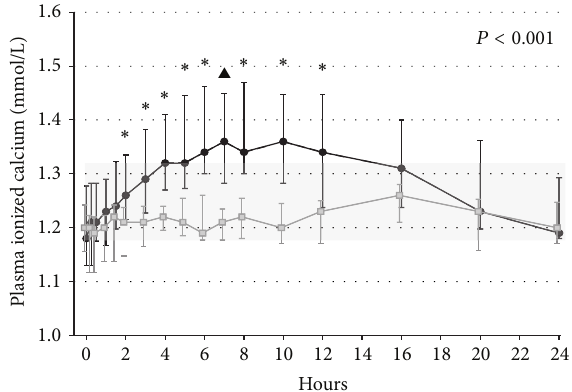
Figure 2: Diurnal variations in plasma ionized calcium levels in patients with hypoparathyroidism following 24 weeks of treatment (black) ( 𝑛 = 21 ) or placebo (gray) ( 𝑛 = with 100 𝜇 g of PTH 1 – 84 17 ). The background light gray square indicates the reference range (1.18–1.32 mmol/l). The 𝑃 value indicates significance between groups by repeated measurements ANOVA. Median with interquar- tile (25% to 75% percentile) range. 󳵳 𝑃 < 0.01 and ∗ 𝑃 < 0.001 by post hoc comparison. Reproduced with permission from JBMR